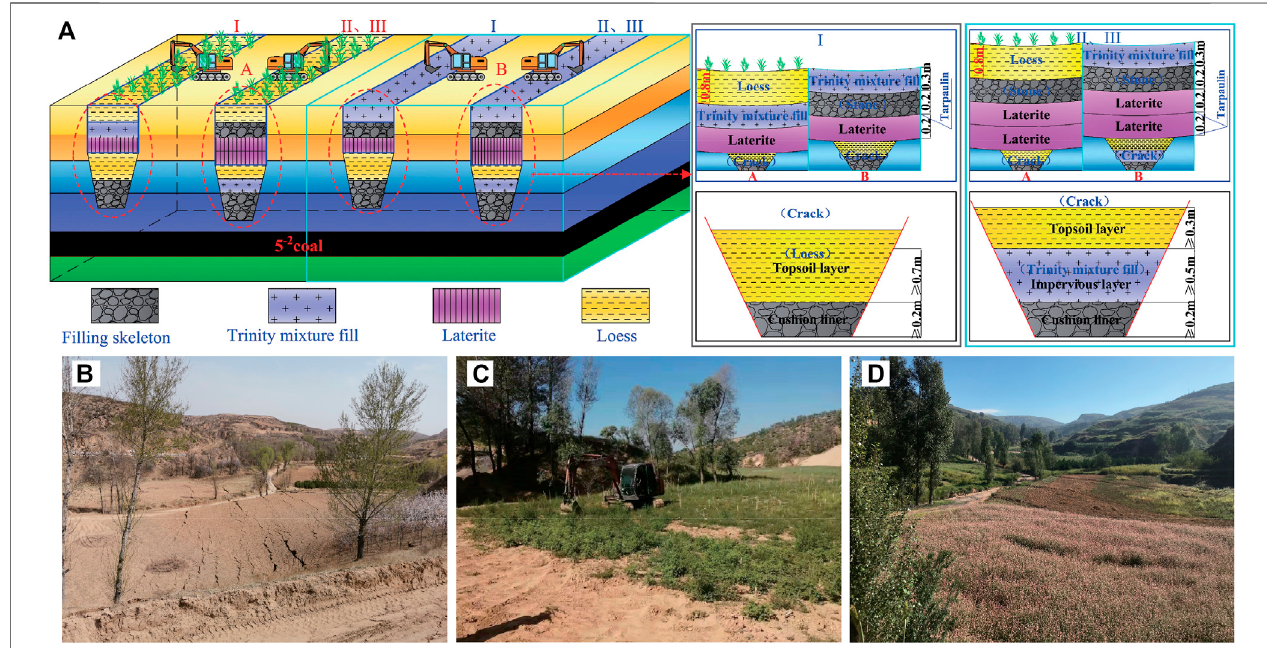
FIGURE 10 | Diagram of ecological restoration and treatment effects: (A) treatment repair schematic; (B) before treatment; (C) during treatment; (D) after treatment.